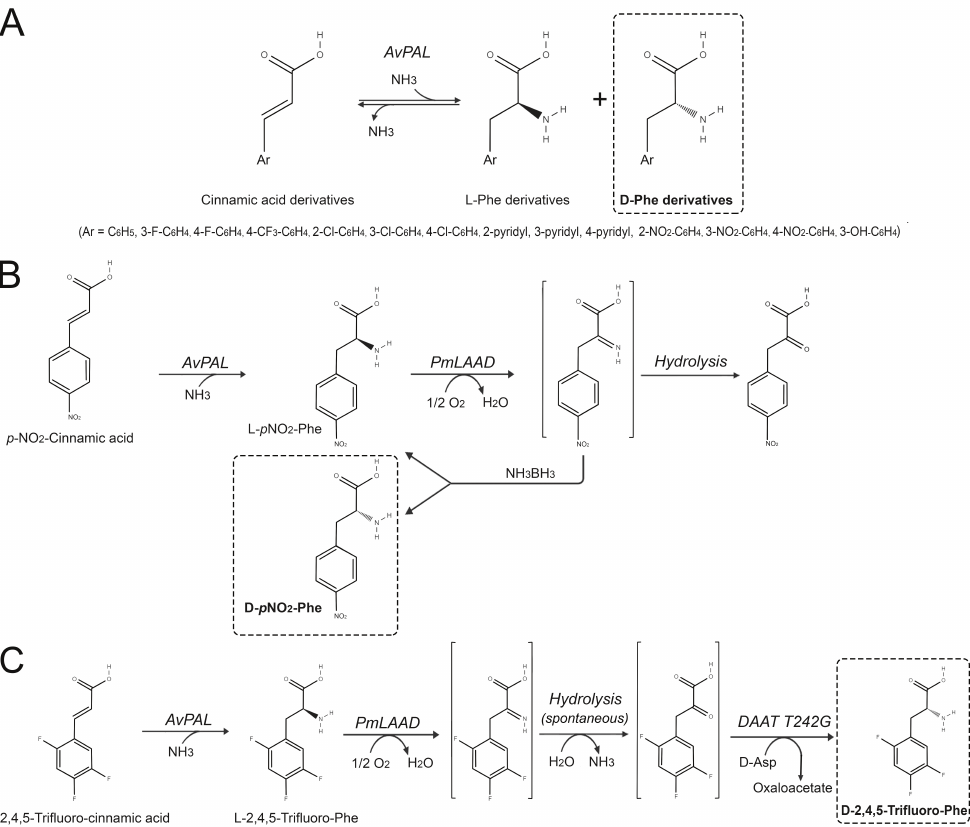
Figure 7. The application of AvPAL in D-AAs synthesis. ( A ) Production of substituted D-phenylalanines by enantioselective hydroamination of cinnamic acid derivatives using AvPAL [44]. ( B ) Production of p NO2-phenylalanine from the corresponding racemate employing AvPAL, P. mirabilis D-amino acid deaminase, and amine borane [45]. ( C ) Chemo-enzymatic pathway for the synthesis of optically pure D-(2,4,5-trifluorophenyl)alaninefrom2,4,5-trifluoro-cinnamic acid generated from trifluorobenzaldehyde using the DAAT T242G variant from Bacillus sp. YM-1, PmLAAD and AvPAL